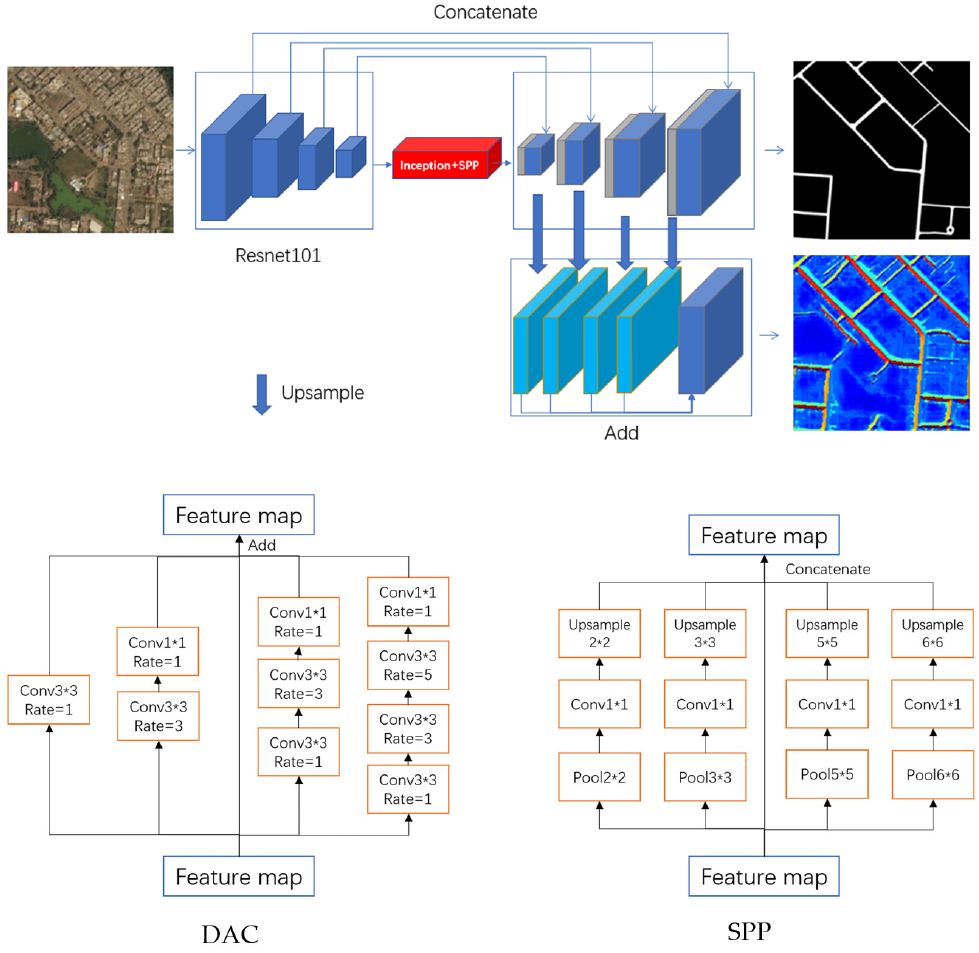
Figure 5. The Structure of the Network for Road Extraction.